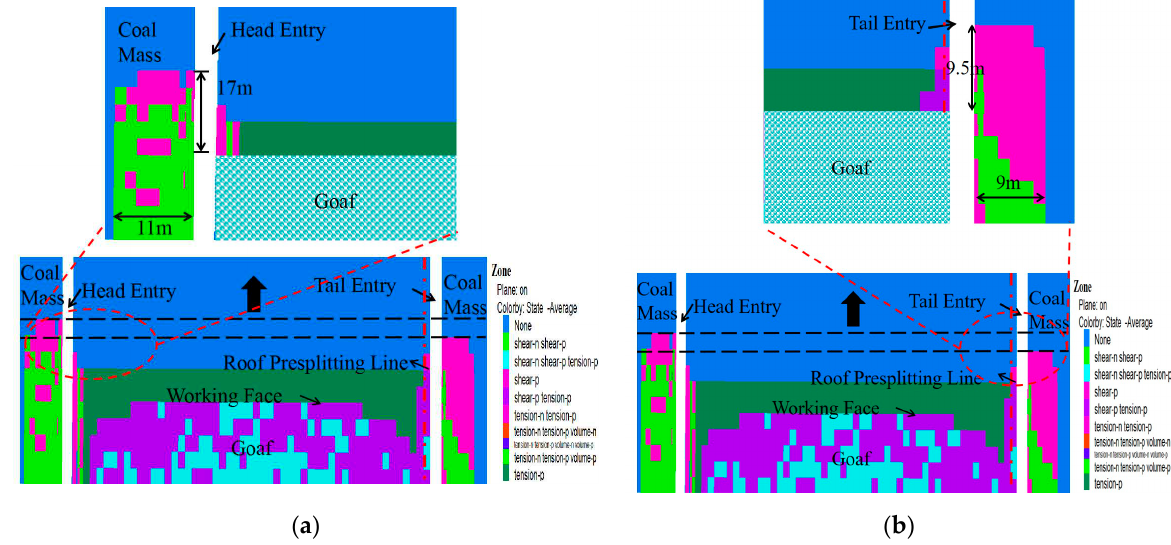
Figure 17. Schematic diagram of plastic zone distribution in roadway: ( a ) Plastic zone of solid coal in the head entry. ( b ) Plastic zone of solid coal in the tail entry.